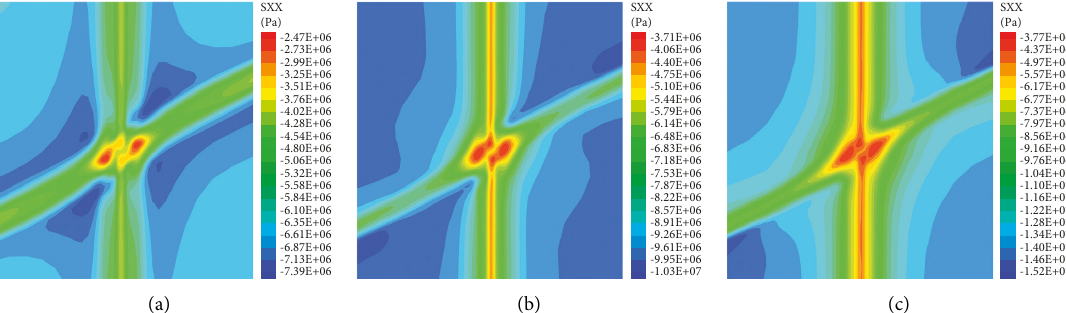
Figure 13: Disturbance influence of stress ratio on surrounding rock horizontal stress of staggered roadways. (a) 0.5 ratio of horizontal stress to vertical stress, (b) 1.0 ratio of horizontal stress to vertical stress, and (c) 1.5 ratio of horizontal stress to vertical